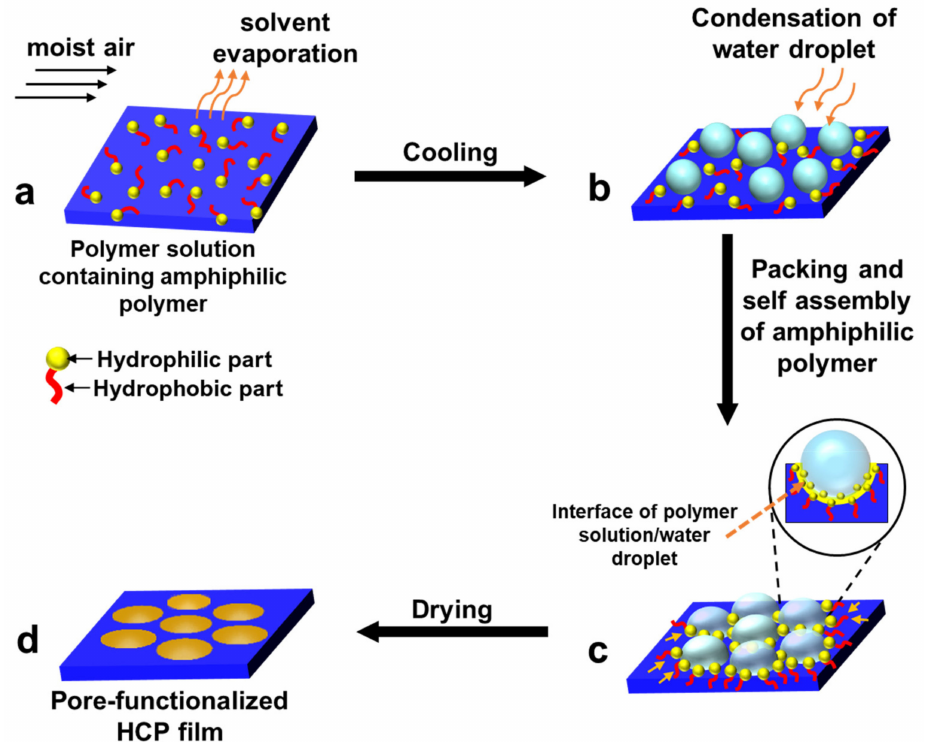
Figure 3. A sequence of stages of pore-selective functionalization by self-assembly of amphiphilic polymer. ( a ) Polymer solution containing amphiphilic polymer in a volatile solvent under humid conditions; ( b ) condensation of water droplets due to cooling of surface temperature; ( c ) close packing of water droplets and self-assembly of hydrophilic part of the amphiphilic polymer around the water droplets; ( d ) formation of pore-functionalized HCP film after